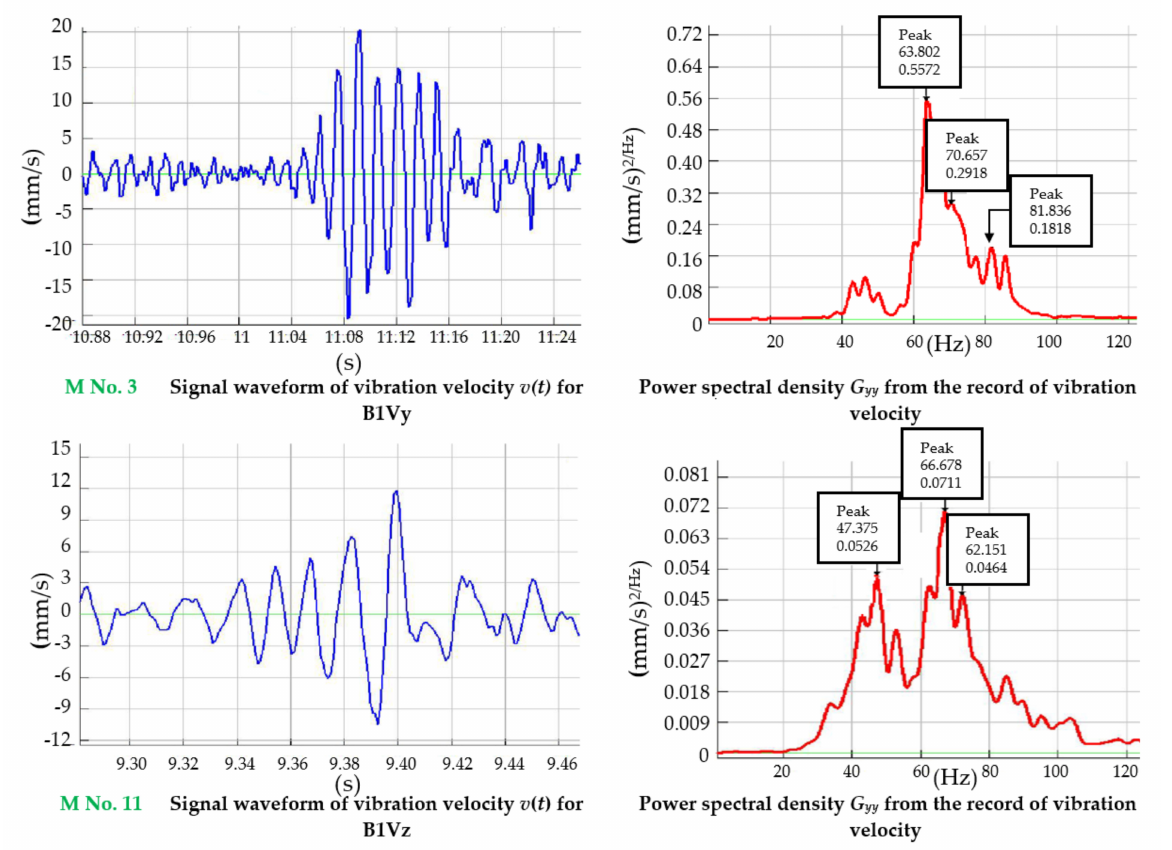
Figure 8. Vibration velocity time history v ( t ) and power spectral density G ii of the vibration velocity recording for measurements for new types of trams.